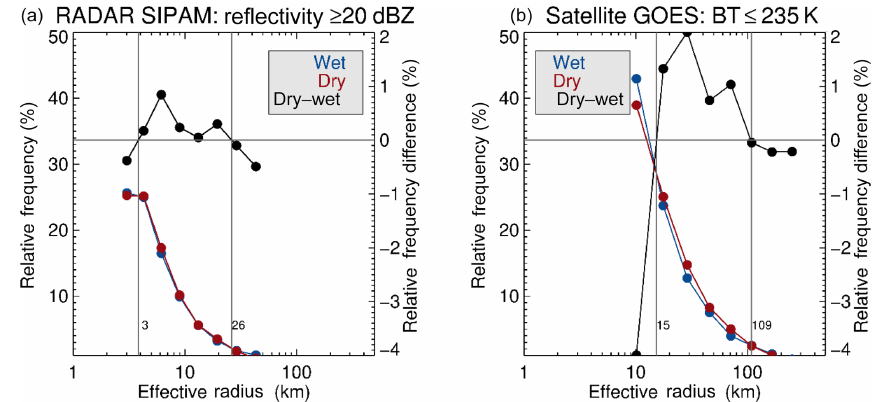
Figure 3. Rain cell ( a , based on the SIPAM S-band radar) and cloud cluster ( b , based on GOES-13 IR brightness temperature; B T ) size distributions between wet and dry seasons and the difference between dry and wet season